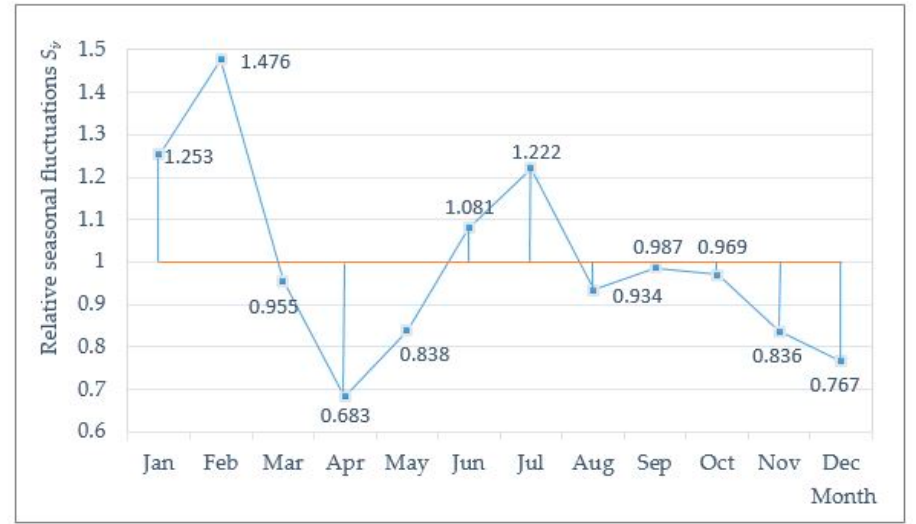
Figure 7. Relative seasonal fluctuations of failure rates in WDN.